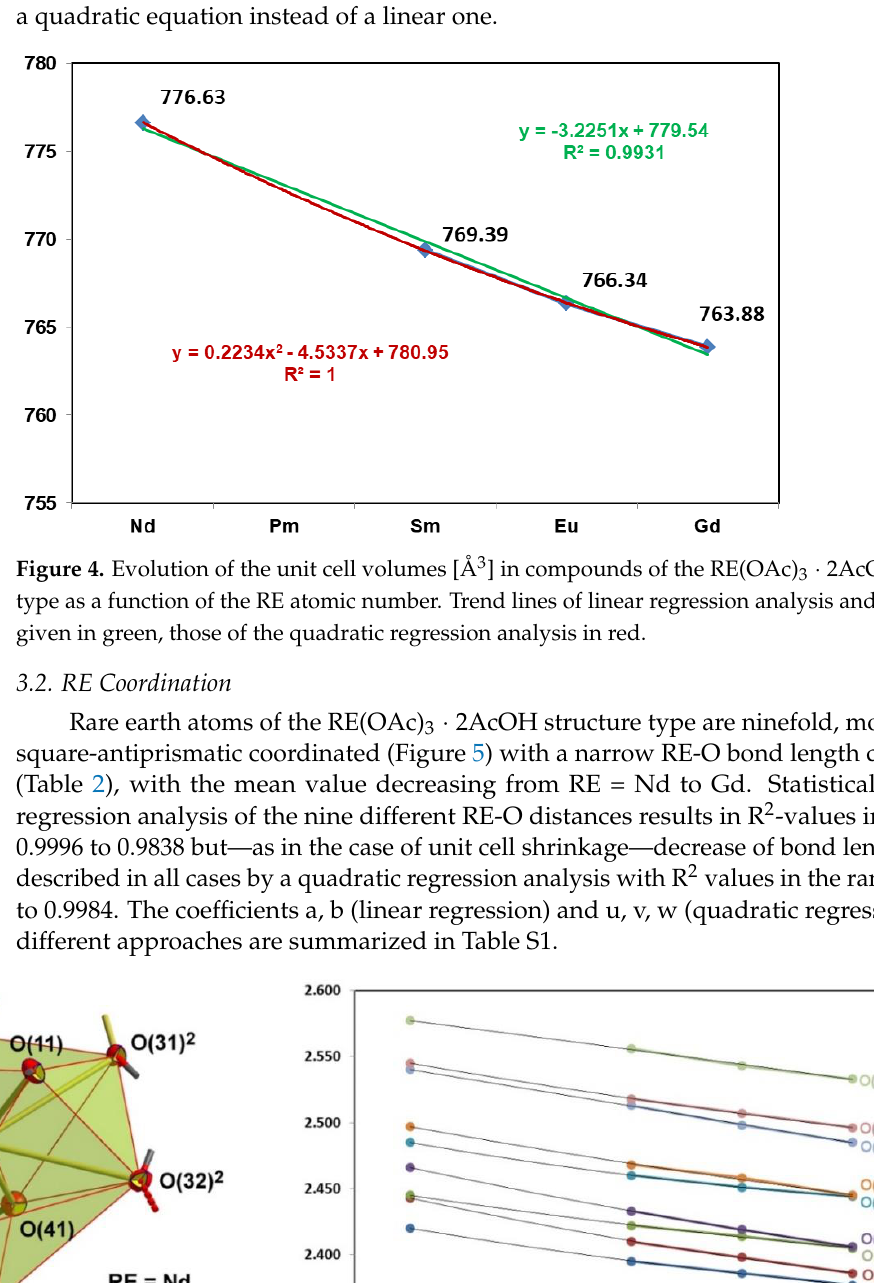
Figure 4. Evolution of the unit cell volumes [Å 3 ] in compounds of the RE(OAc) 3 · 2AcOH structure type as a function of the RE atomic number. Trend lines of linear regression analysis and formula are given in green, those of the quadratic regression analysis in red.